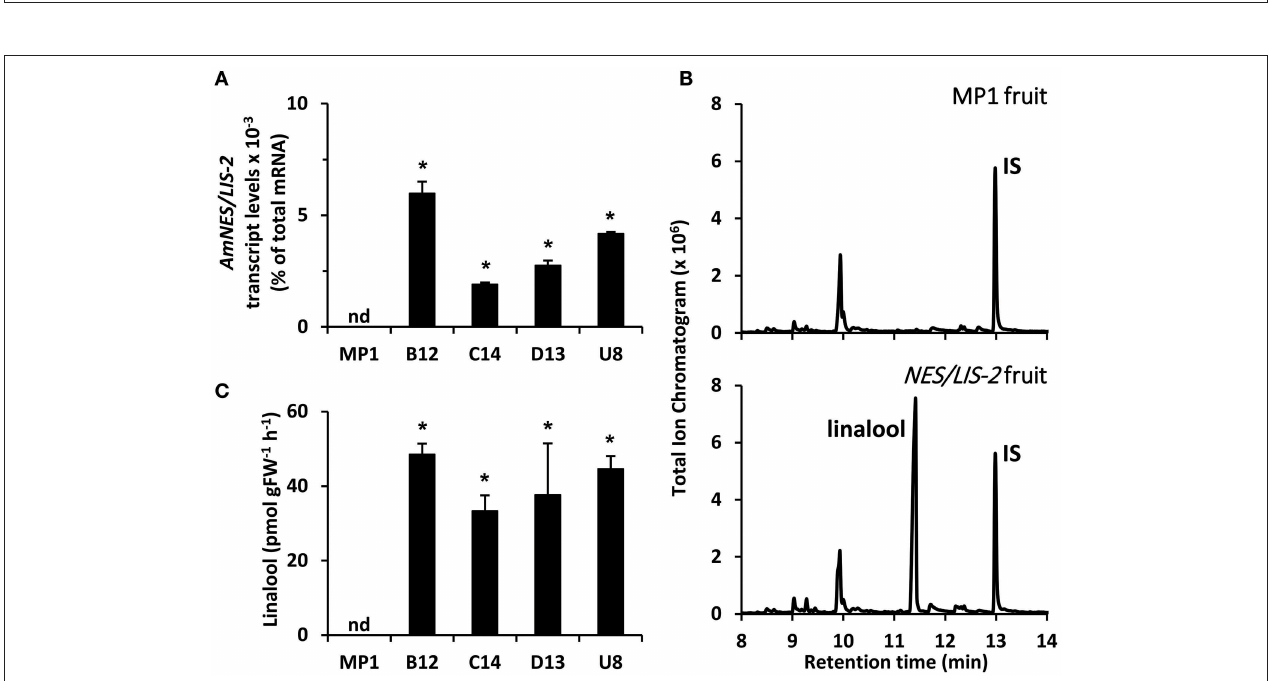
FIGURE 3 | Profiling of transgenic tomato lines overexpressing AmNES/LIS-2 under control of the PG promoter. (A) Transcript levels of AmNES/LIS-2 in fruits (Br + 3 stage) of MP1 control and AmNES/LIS-2 lines B12, C14, D13, and U8 determined by qRT-PCR (means ± SEM, n = 3 biological replicates). (B) Profiling of terpenes collected as emitted volatiles from ripe tomato fruits (MP1 control and AmNES/LIS-2 line U8) and analyzed by GC-MS. IS, internal standard. (C) Quantitative changes in amounts of linalool collected as emitted volatile from fruits of MP1 and AmNES/LIS-2 lines. Data are means ± SEM ( n ≥ 3). * P < 0.05 AmNES/LIS-2 lines relative to MP1 by Student’s t -test. FW, fresh weight; nd, not